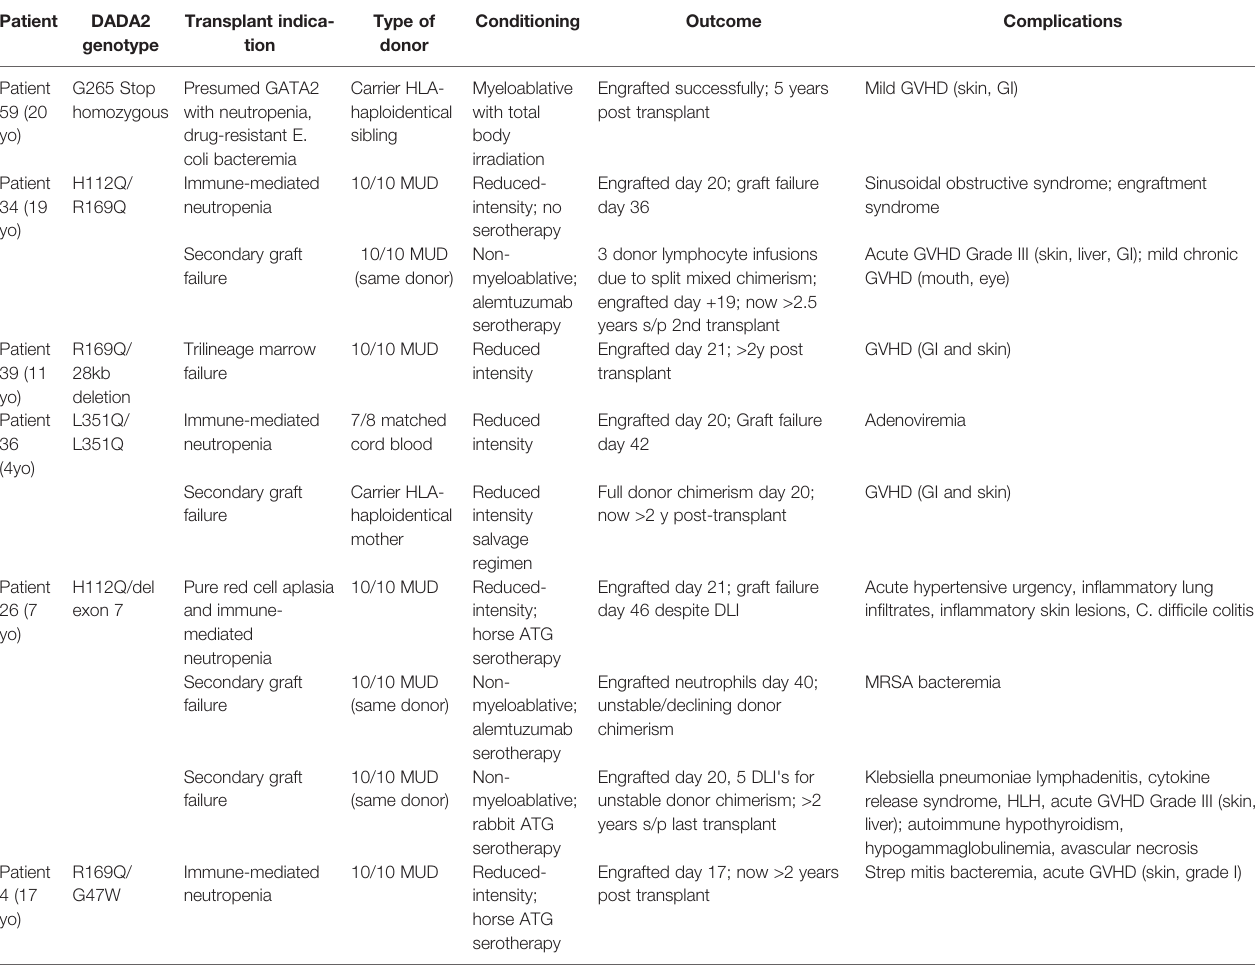
TABLE 3 | Summary of patients receiving